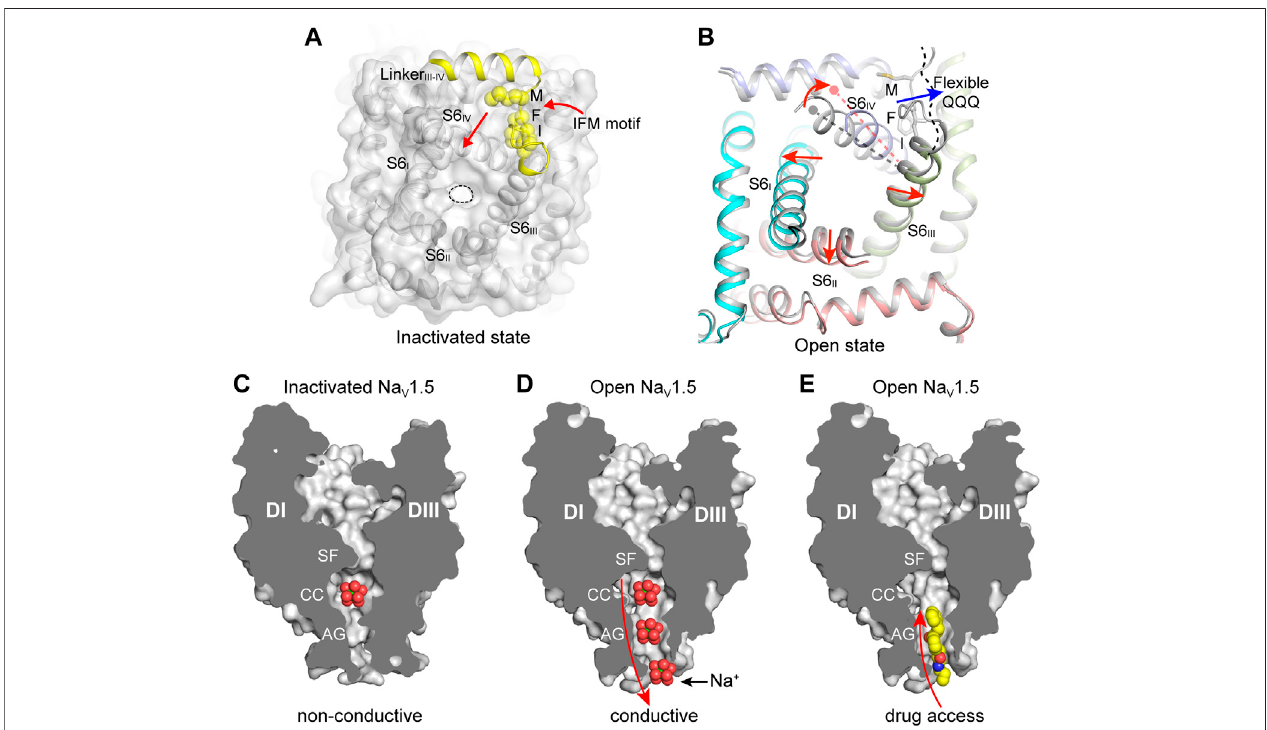
FIGURE4| TheIFM-motif mediatedfastinactivationandtheopenactivationgate. (A) AllostericinhibitionofmammalianNa V channelsbytheIFM-motif(PDBcode: 6J8I). The pore domain viewed from cytosol is shown in surface. The IFM-motif shown in yellow spheres. (B) Releasing of the IFM-motif leads to channel opening. Activation gate comparison between rat Na V 1.5 (PDB code: 6UZ3) and Na V 1.5/QQQ (PDB code: 7FBS). Red arrows indicate the S6 helix shift. (C) Non-conductive ion pathoftheinactivatedstateNa V channel(PDBcode:6UZ3). (D) Na + conductiveionpathoftheopen-stateNa V channel(PDB code:7FBS). (E) Theopenactivation gate of Na V channel provides potential accessing path for the open-state blockers. Propafenone is shown in